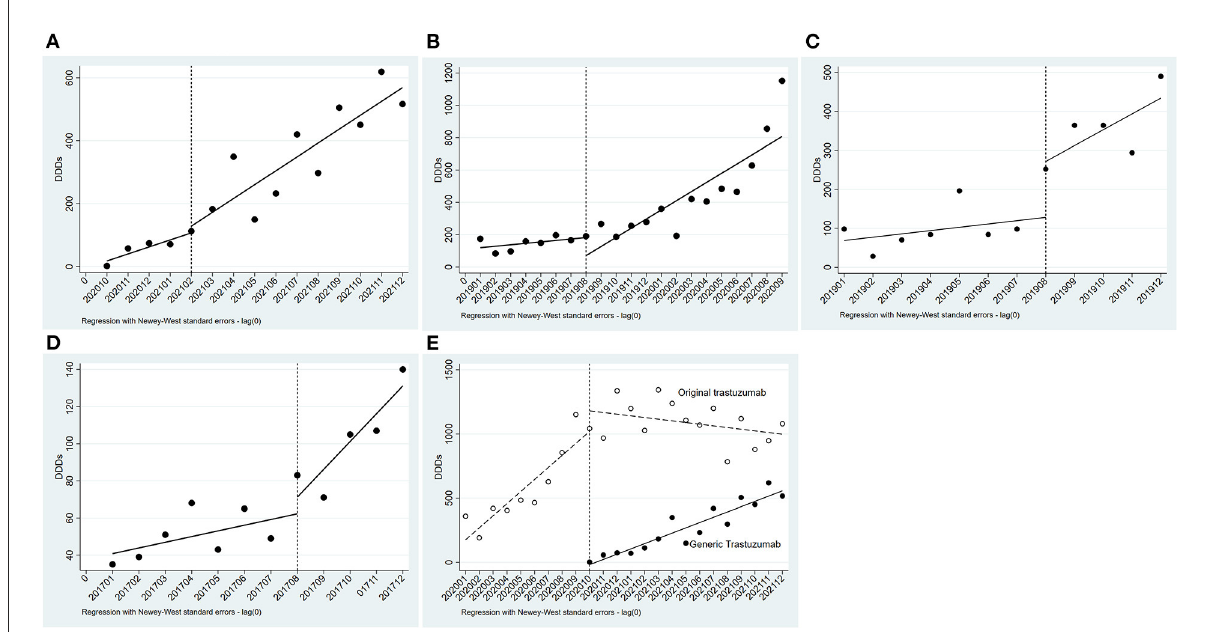
FIGURE5 Results of the regression analysis of DDDs before and after policy implementation. (A) Regression analysis of DDDs of generic trastuzumab before and after insurance coverage; (B) Regression analysis of DDDs of original trastuzumab before and after insurance coverage and price negotiation; (C) Regression analysis of DDDs of original trastuzumab before and after price negotiation; (D) Regression analysis of DDDs of Lapatinib before and after price negotiation; (E) Regression analysis of DDDs of trastuzumab before and after low-price generic